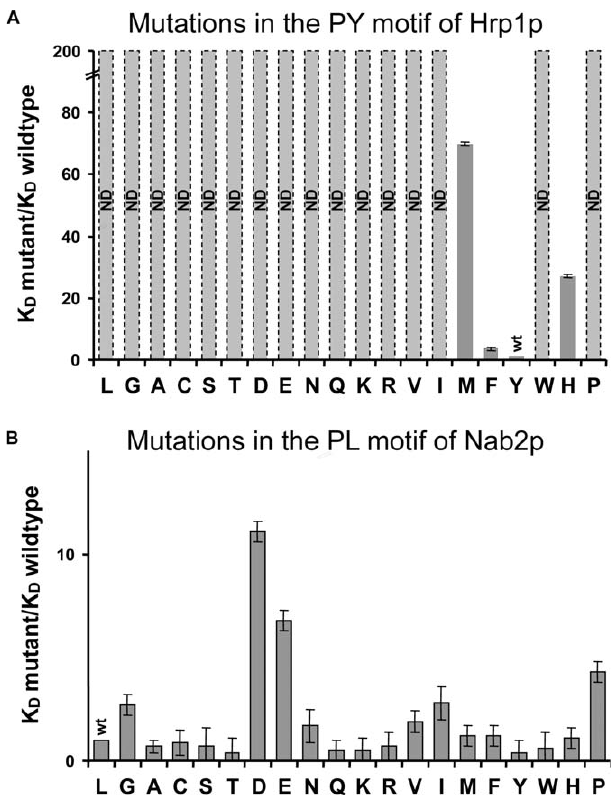
Figure 5. Mutagenic Analysis of the PY(L) Motif (A) Mutations in the PY motif of Hrp1p and the resulting fold decrease in binding affinity for Kap104p. Only M, F, and H can substitute for the Y. All other mutations had no detectable (ND) binding by ITC. (B) Mutations in the PL motif of Nab2p and the resulting fold decrease in binding affinity for Kap104p.